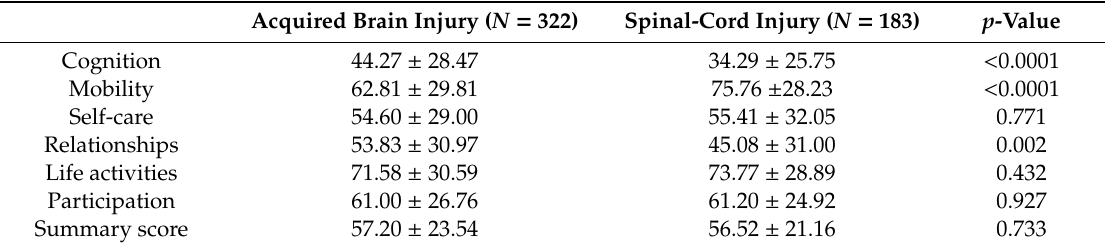
Table 2. Comparison of World Health Organization Disability Assessment Schedule 2.0 (WHODAS 2.0) scores of overall disability across domains between participants with brain and spinal-cord injuries.